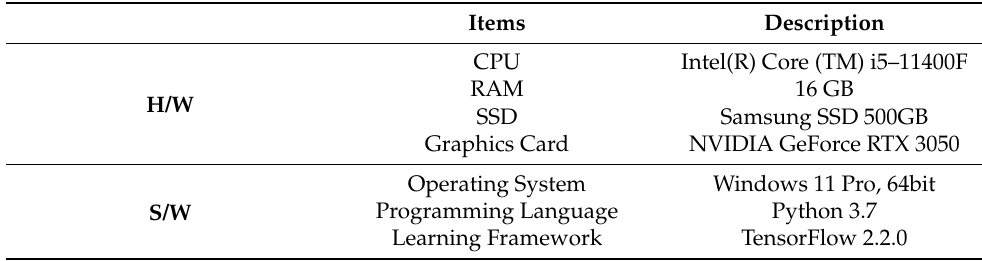
Table 1. Mainframe hardware and software for workstations.